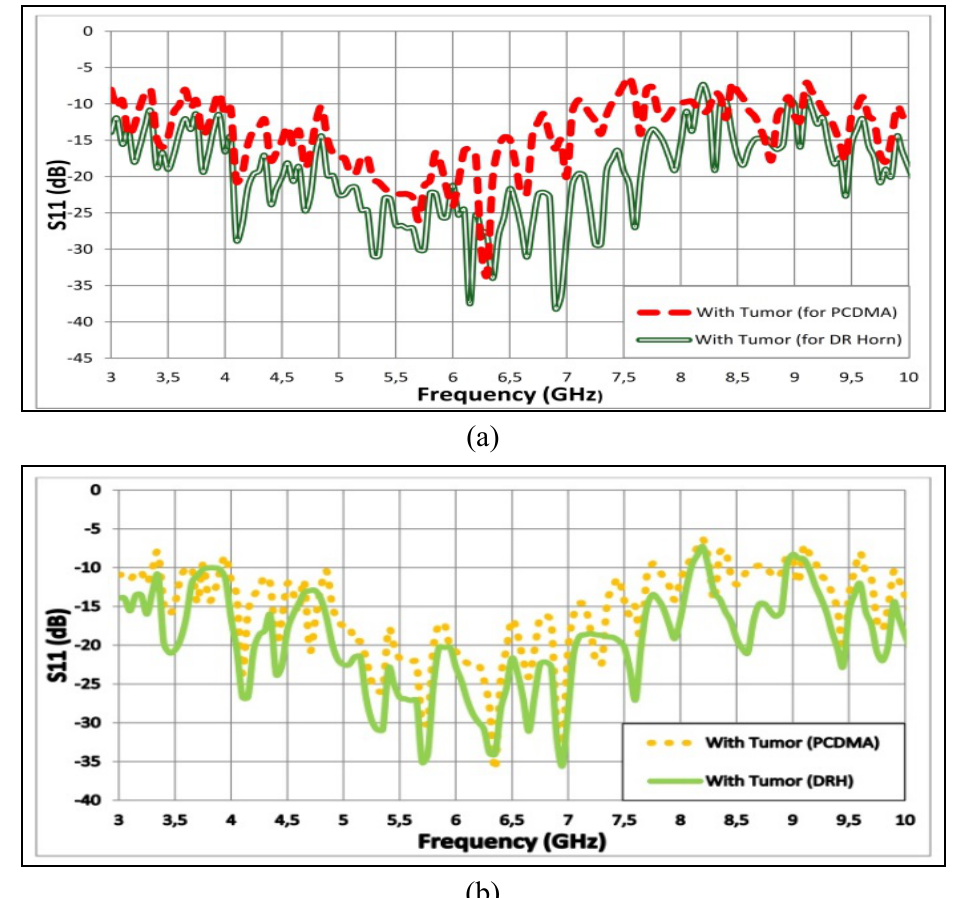
FIGURE 6. Experimental measurements for tumorous cases: a) Return loss results obtained by using both DRH and PCDMA, b) Return loss results when the tumor is at the depth of 45